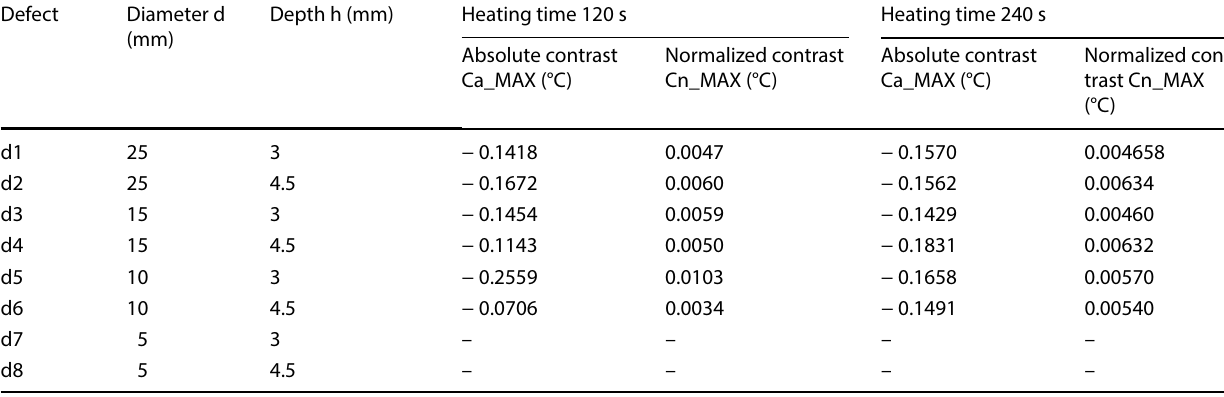
Table 7 Absolute and normalized contrast for the SMArt thermography